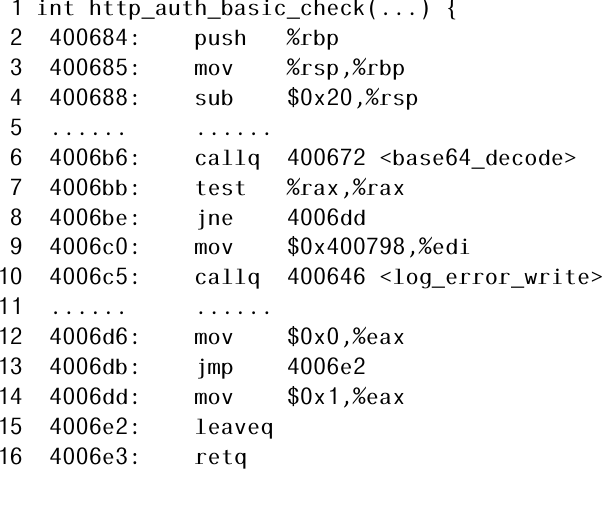
Figure 3. Assembly code from